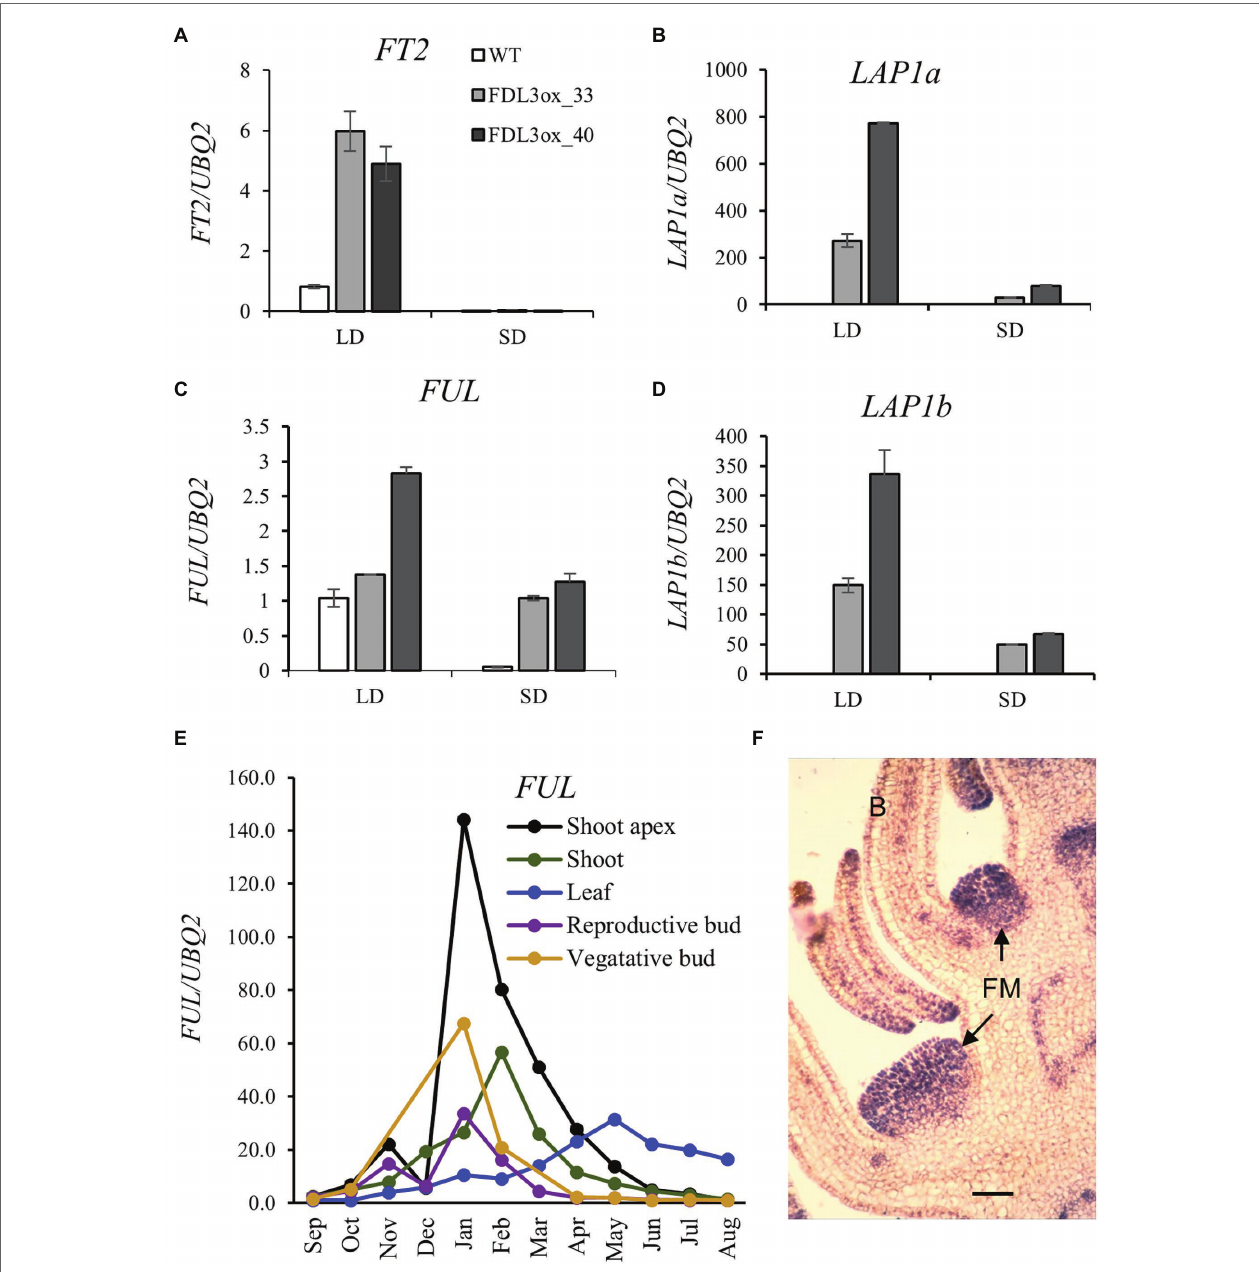
FIGURE 8 | FDL3ox and daylength alter expression of FT2 and three AP1/FUL homologs with diverse vegetative and reproductive expression patterns. (A–D) Fully expanded leaves were collected from WT and two independent events of FDL3ox plants grown for 2 months in LDs, followed by 3 weeks in SDs. Relative fold changes in transcript levels of FT2 (A) , LAP1a (B) , FUL (C) , and LAP1b (D) . Expression of the other two members of the AP1/FUL family ( Supplementary Figure 8 ), MADS14 and MADS28 , was not detectable in either LDs or SDs. The expression was normalized against reference gene UBQ2 . (E) Seasonal expression pattern of FUL in adult Populus deltoides . Relative expression is fold change in transcript levels relative to the time point with the lowest expression within a tissue ( n = 3 biological replicates except that three technical replicates were assayed from a pool of three shoot apices). (F) In situ hybridization showing LAP1b expression in initiating floral meristems of an immature male Populus trichocarpa inflorescence. FM, floral meristem; B, bract. Scale bar = 100 μ m. Additional LAP1a and LAP1b in situ hybridizations are provided in Supplementary Figure S12